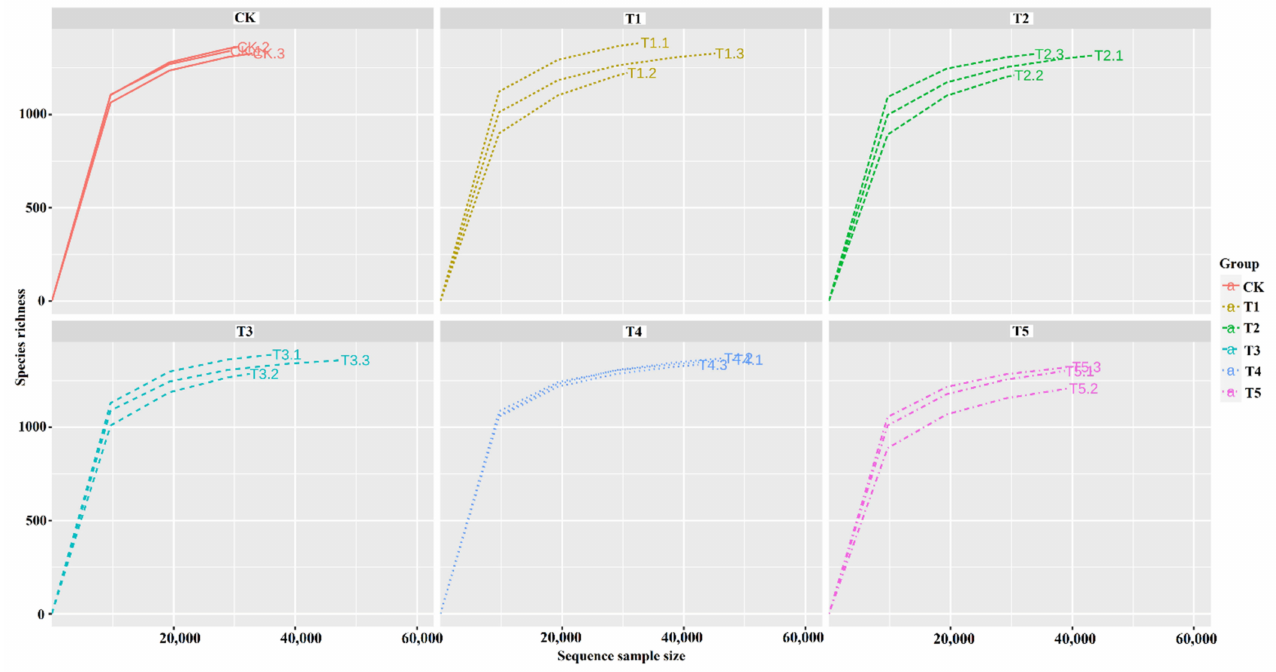
Figure 3. The rarefaction curve of bacterial species richness and sequencing sample size.